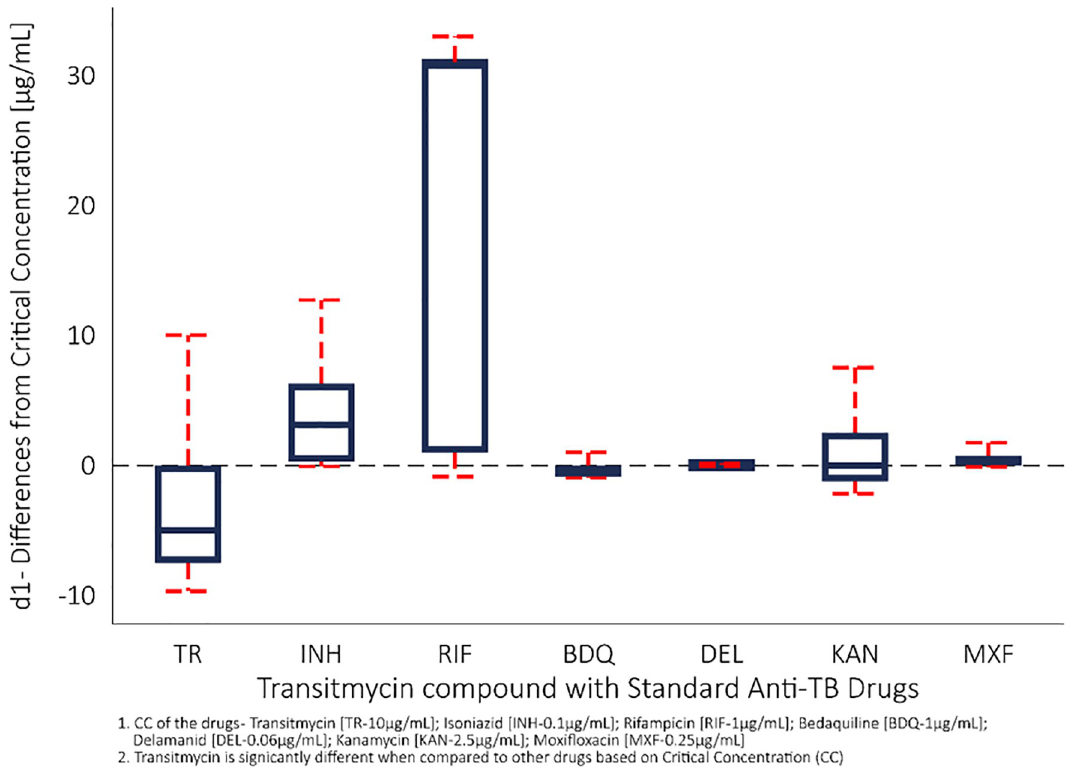
Fig 2. The extent that the MICs (n = 50) differ from the observed critical concentration (CC) of TR in comparison to INH, RIF, BDQ, KAN, MXF, and DEL.